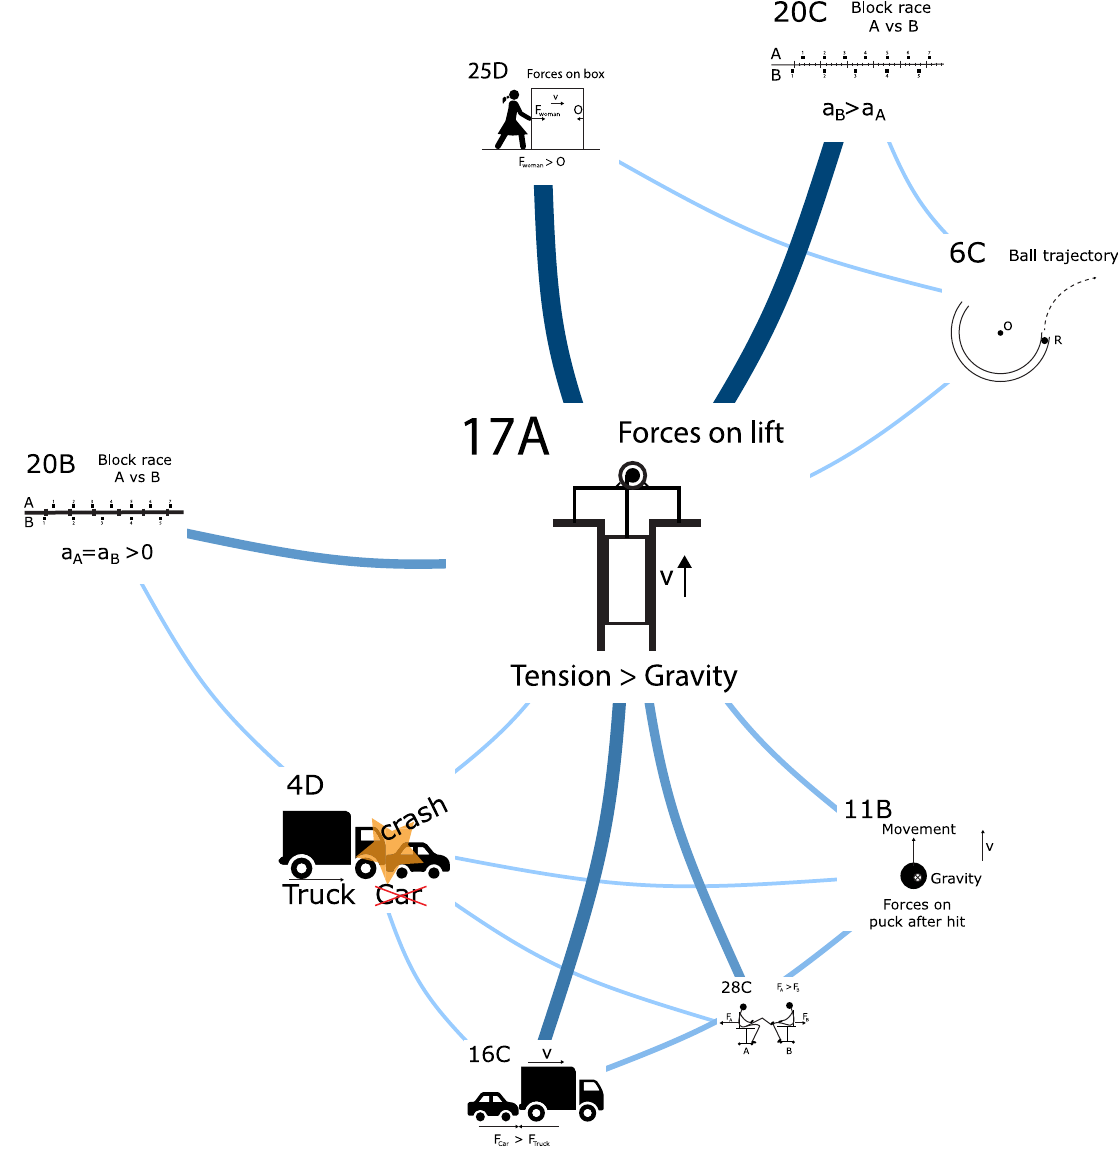
FIG. 11. Illustration of the third module, which has two main interpretations; force as competition or lack of distinction between velocity and acceleration using pictograms. Each pictogram represents a response